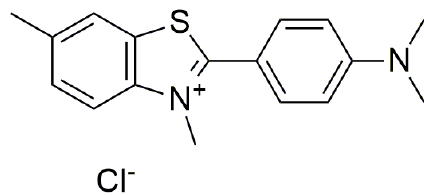
Figure 15. Chemical structure of thioflavin T (ThT).